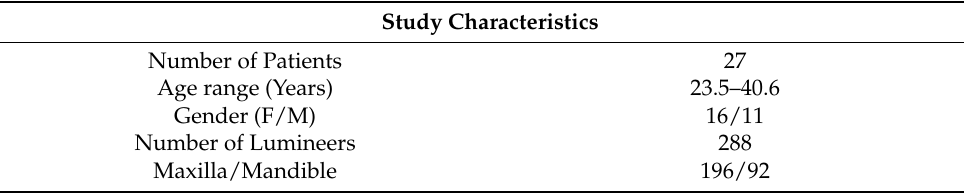
Table 1. General characteristics of the study population.